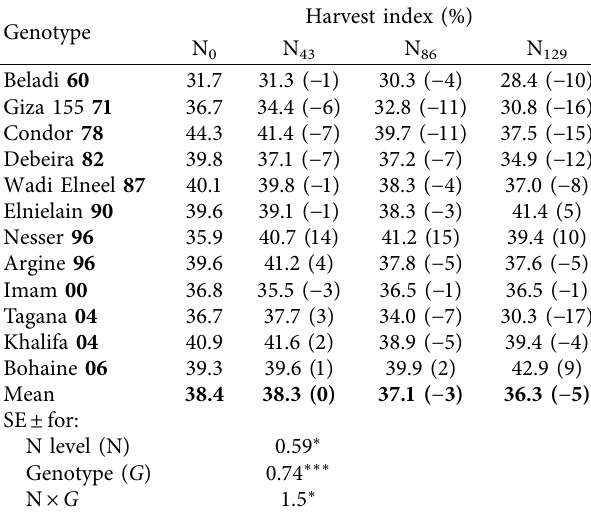
Table 4: Nitrogen use efficiency (NUE) of 12 bread wheat geno- types grown in season 2006/07 and 2007/08 under different N levels at Gezira Research Station Farm, Wad Medani,